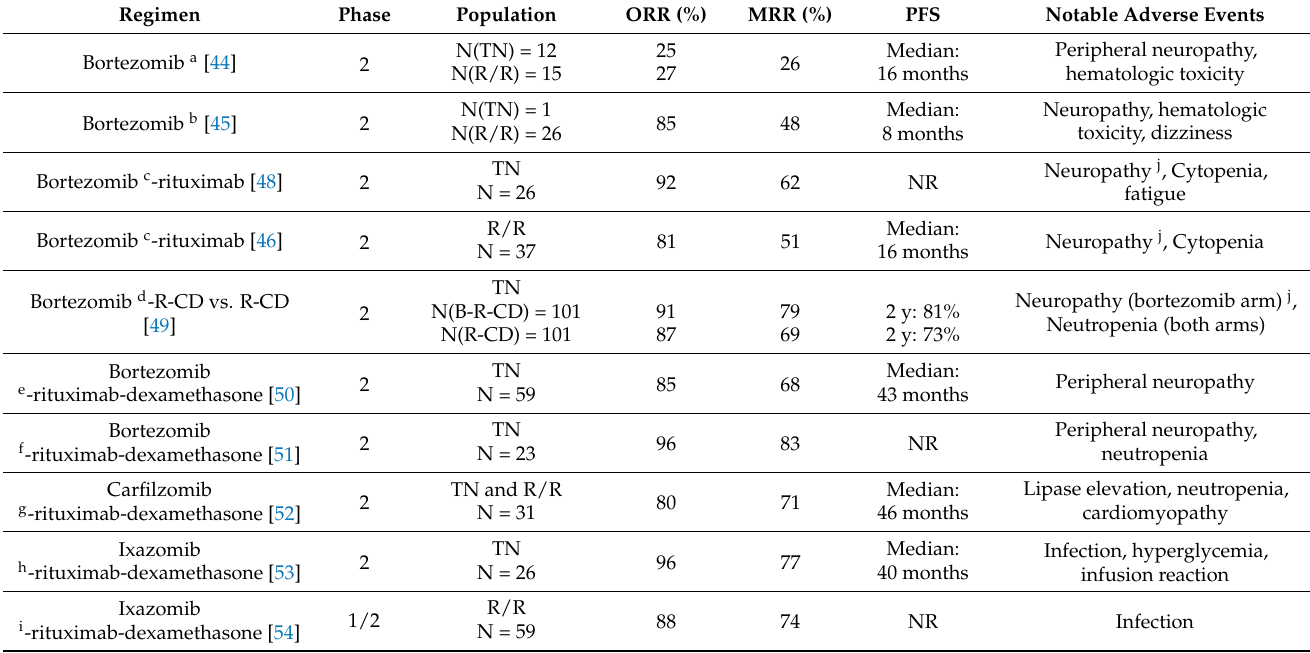
Table 2. Notable clinical trials evaluating proteasome inhibitors in Waldenström